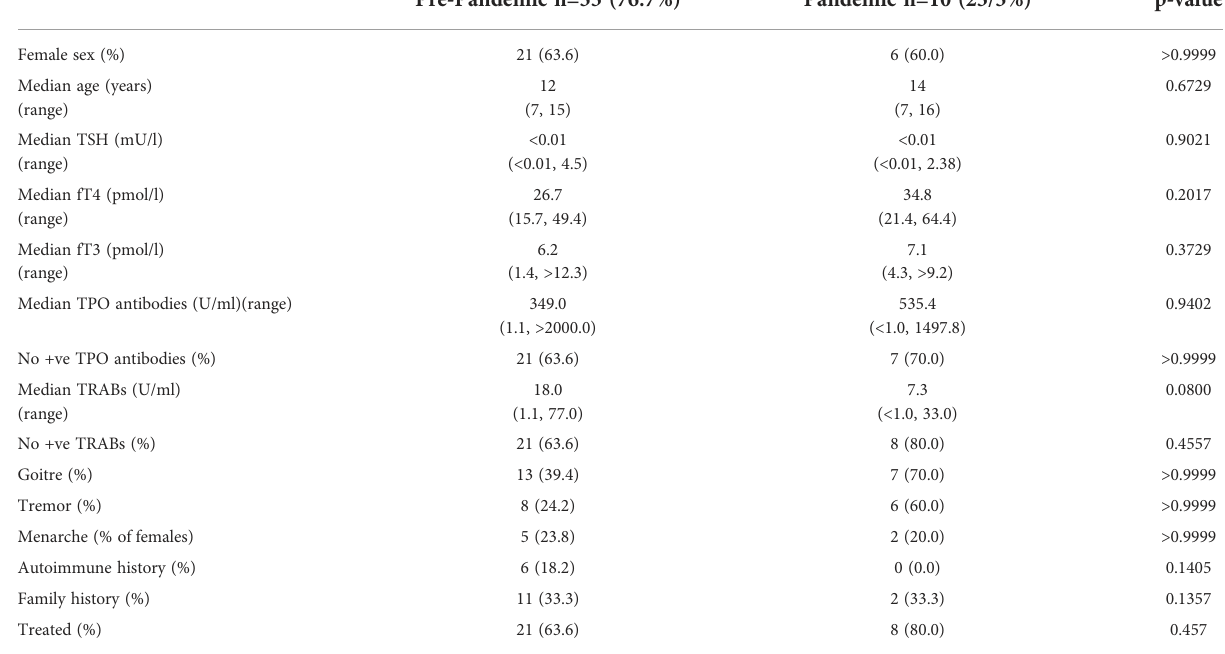
TABLE 1 Characteristics of hyperthyroid patients.